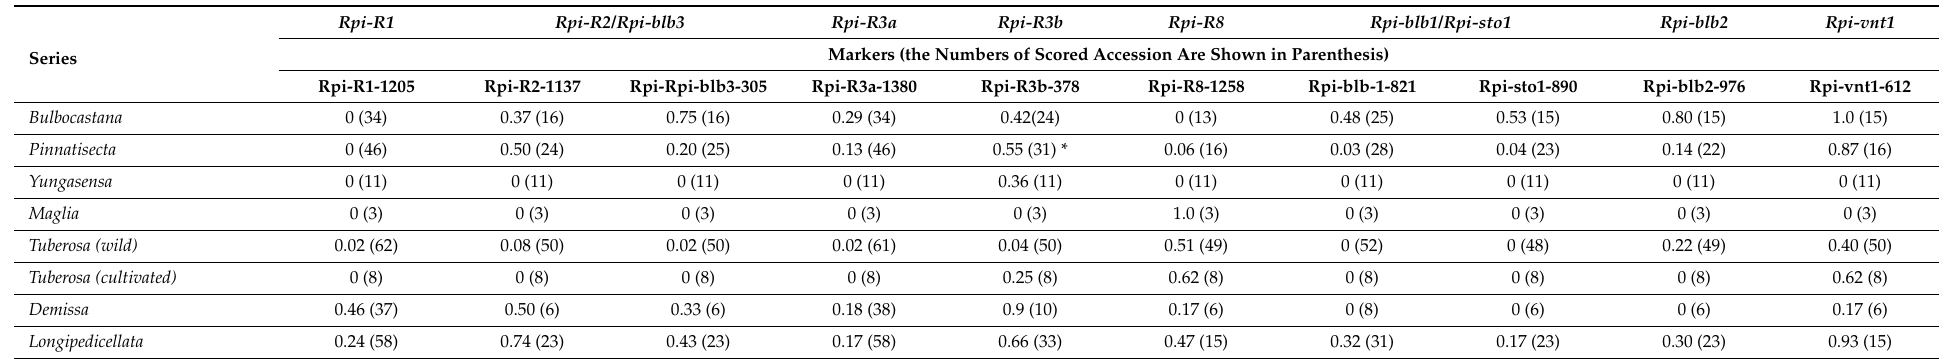
Table 3. Screening Solanum species from the seven taxonomic series of Section Petota Dum. with SCAR markers of the Rpi genes. Frequency of the markers (the number of accessions analyzed).